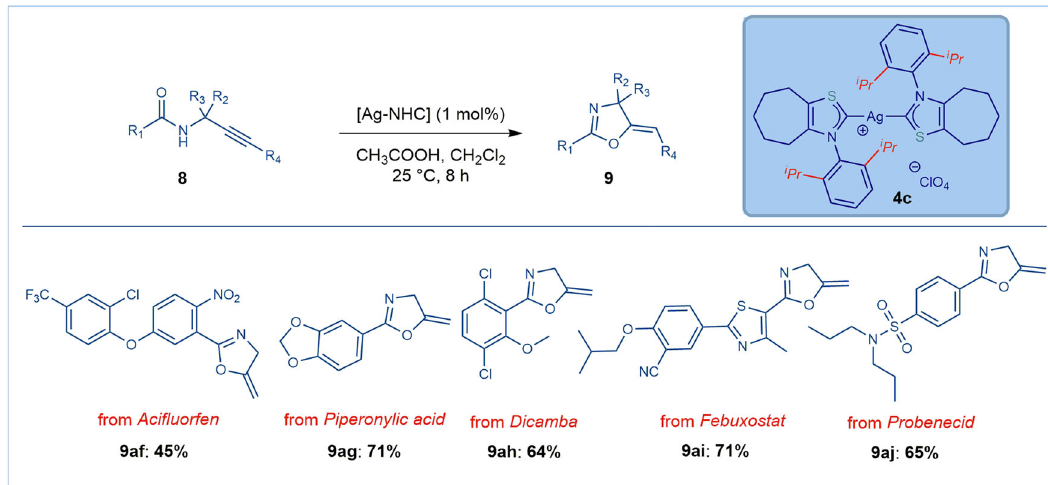
Fig. 8 Late-stage functionalization in Ag – NHC-catalyzed cyclization of N -propargylic amides. Conditions: amide (1.0 equiv), catalyst 4c ([Ag], 1 mol%),